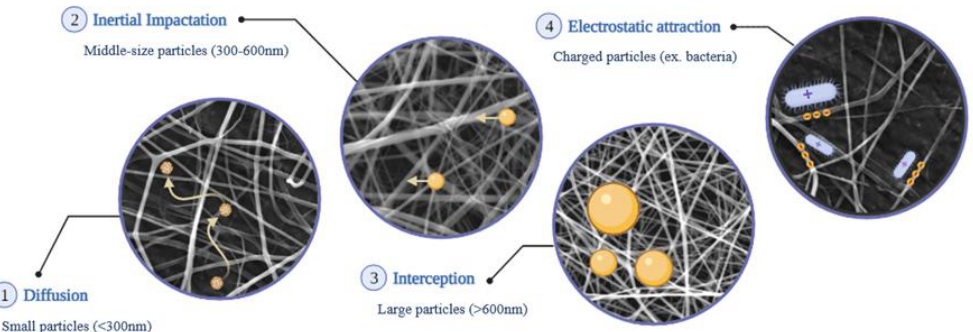
Figure 4. Main filtration mechanisms of fibrillar structures for small ( 1 ), middle-size ( 2 ) and large particles ( 3 ), as well as electrostatic attraction ( 4 ).